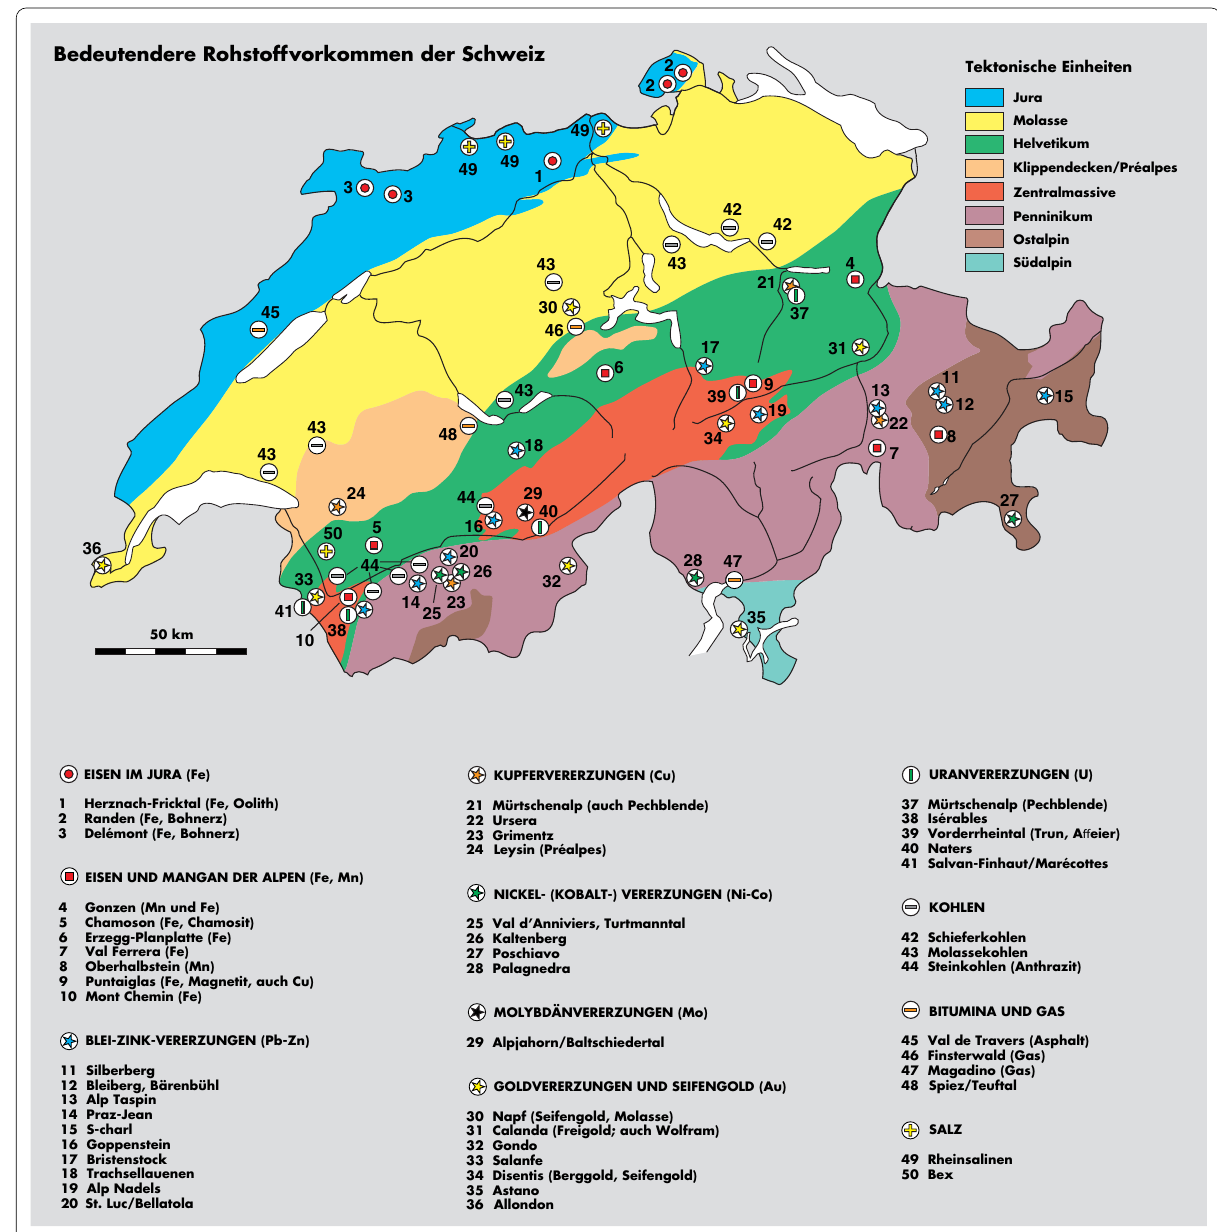
Fig. 10 Occurrences of important mineral resources (hydrocarbons, ores, salt) in Switzerland in the twentieth century (reproduced from Kündig et al., 1997). Red circle : Fe ores in the Jura fold-and-thrust beld, red square : Fe and Mn ores in the Alps, blue star : Pb–Zn ores (the missing number to the blue star in the very southwest labels the occurrences at Mont Chemin), orange star : Cu ores, green star : Ni-Co ores, black star : Mo ores, yellow star : Au ores and placer, blue-green vertical dash : U ores, grey dashes : coal, orange dash : asphalt and gas, yellow cross :